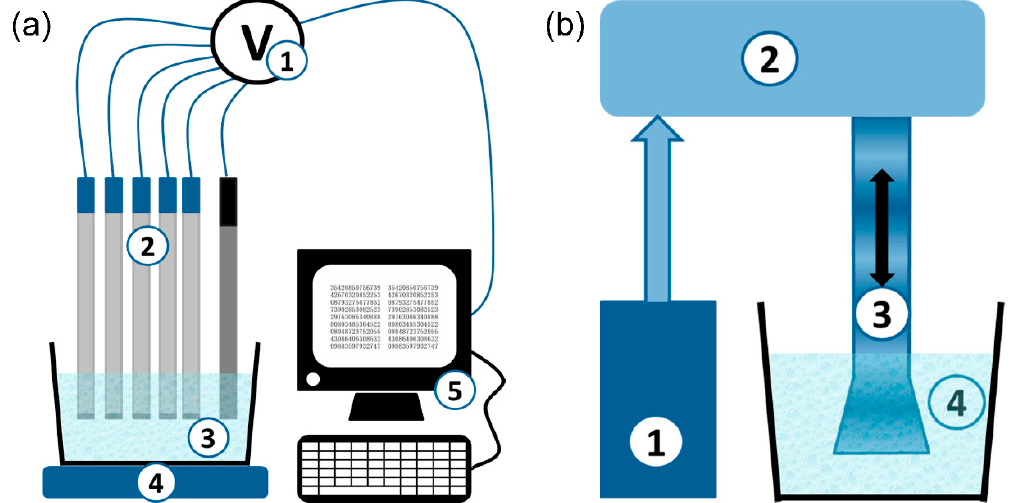
Figure 1. ( a ) Scheme of the potentiometric multisensor system. 1—multichannel digital mV-meter;